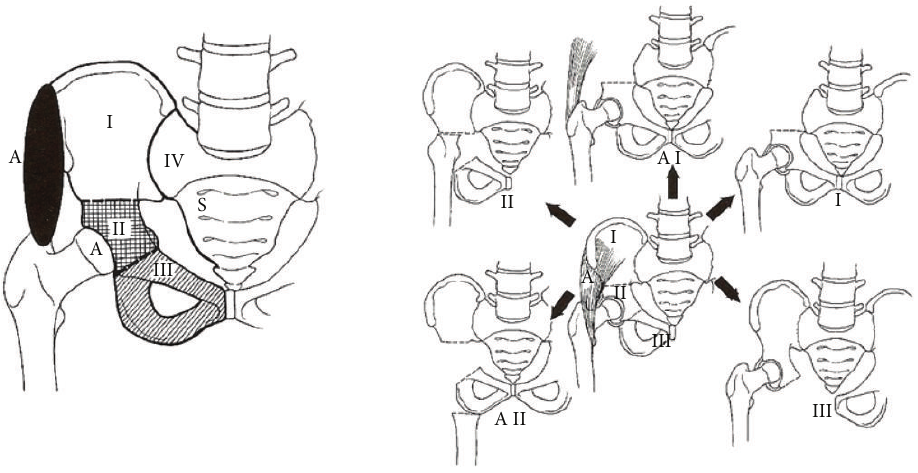
Figure 1: A Classification of pelvic resection